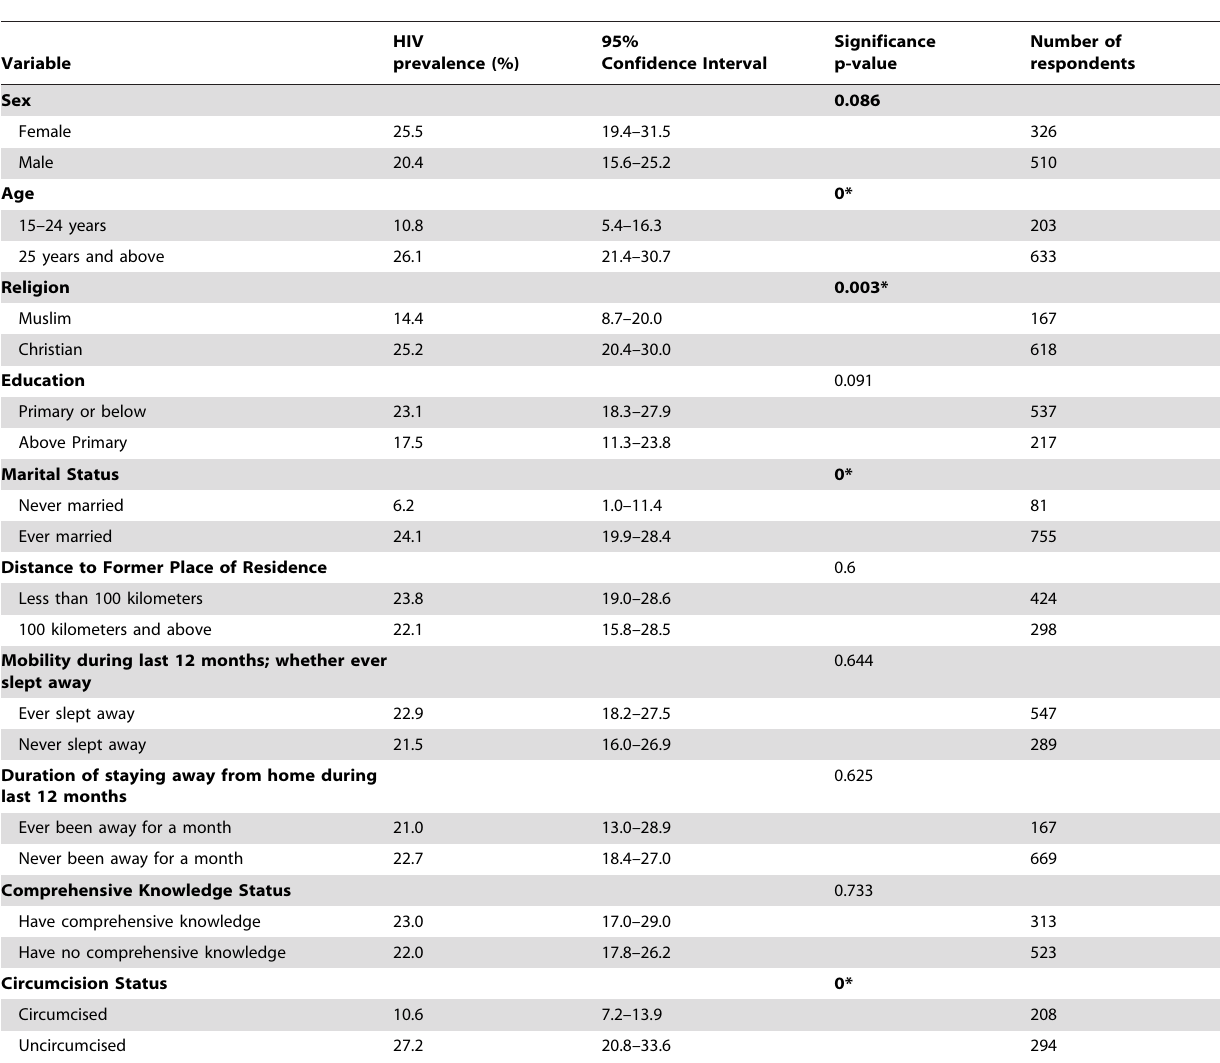
Table 3. Estimated prevalence of HIV by HIV-related variables among fishing community members age 15–49